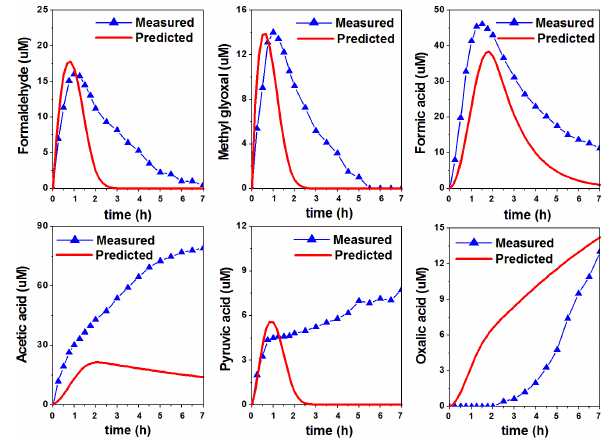
Fig. 9. Measured and predicted concentrations of small products from the MACR–OH reaction.